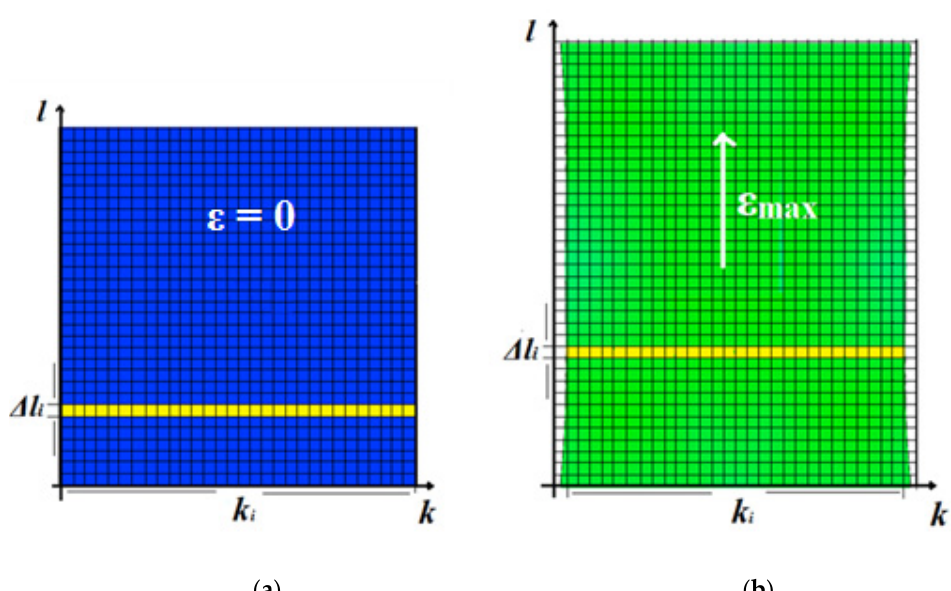
Figure 10. Illustration for resistance calculation for samples of arbitrary shape: ( a ) undeformed and ( b ) deformed state.